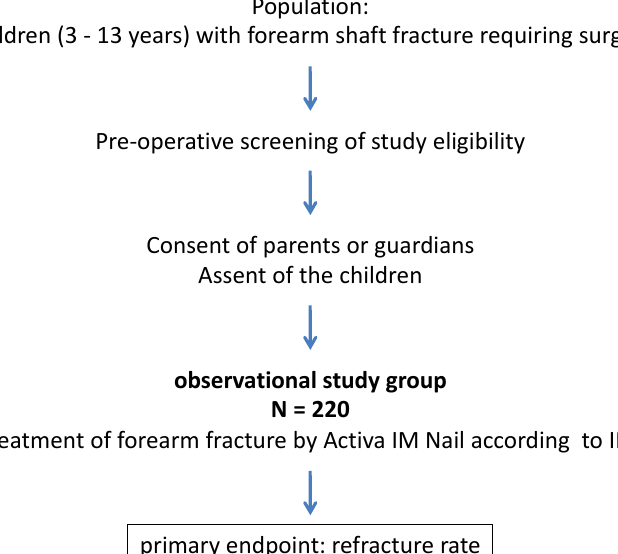
Figure 1. Flow chart of the trial design.